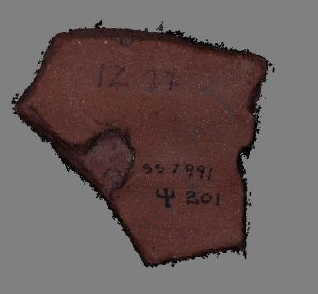
Figure 8. 3D model of the handle from Chios